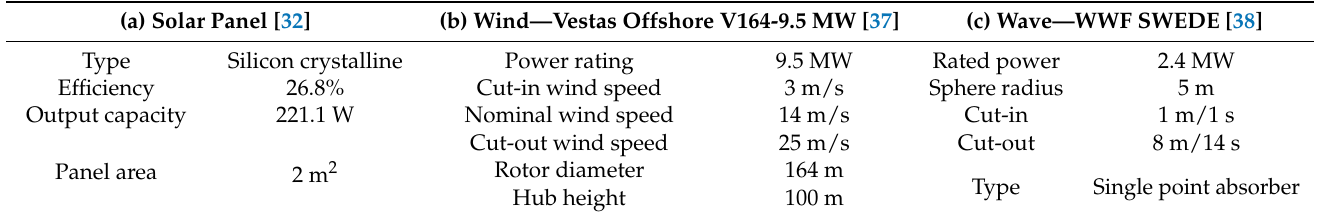
Table 2. Technical specifications of the renewable systems